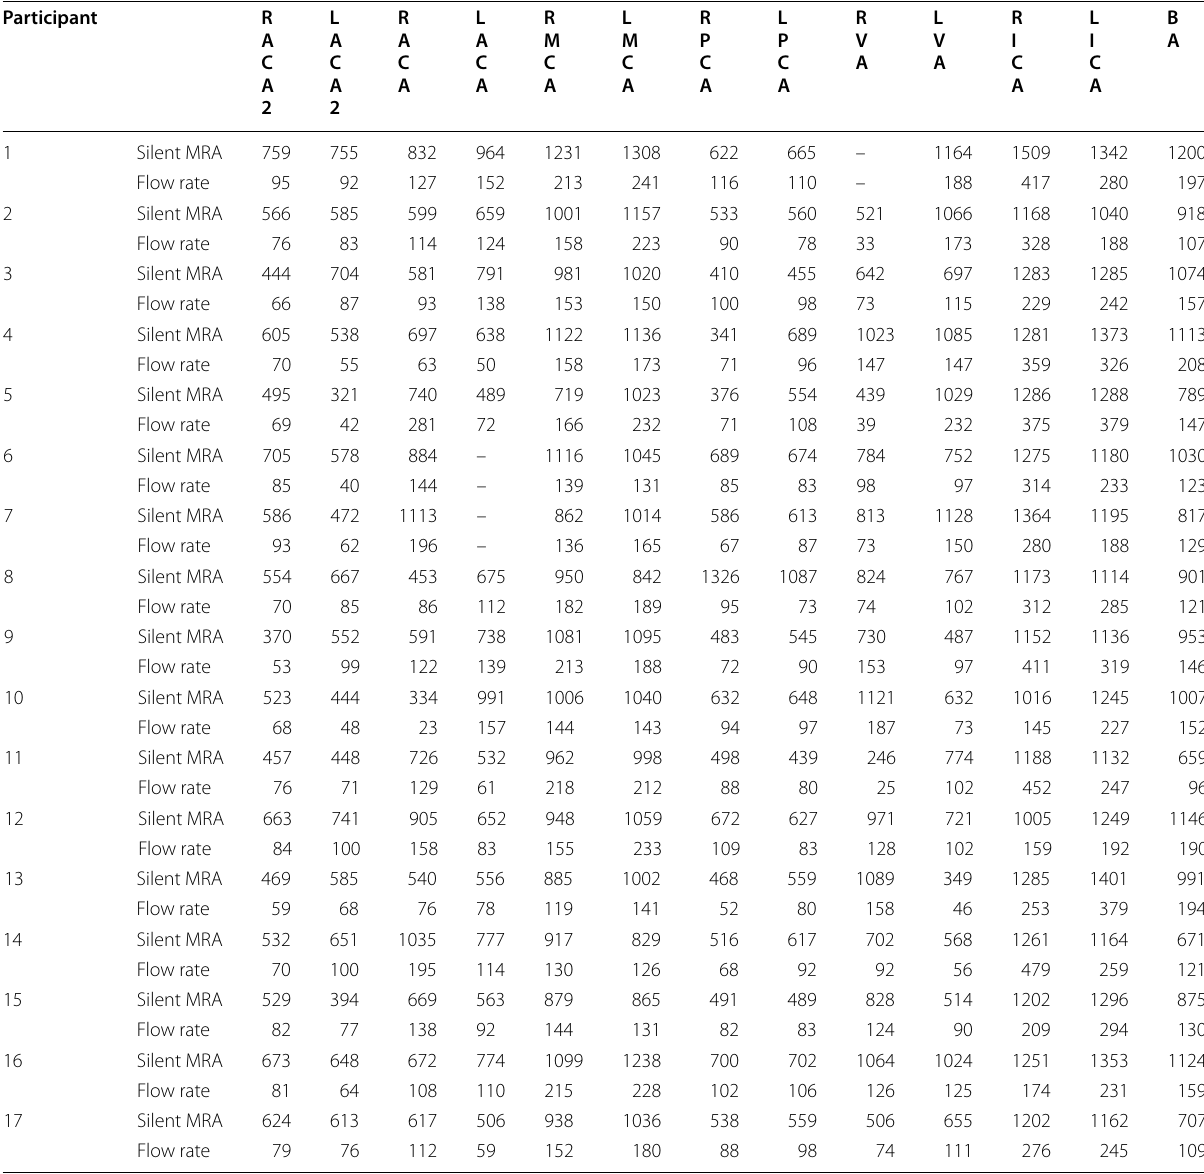
Table 1 Image intensities in silent MRA and corresponding flow rates determined using 2D PC‑MRA